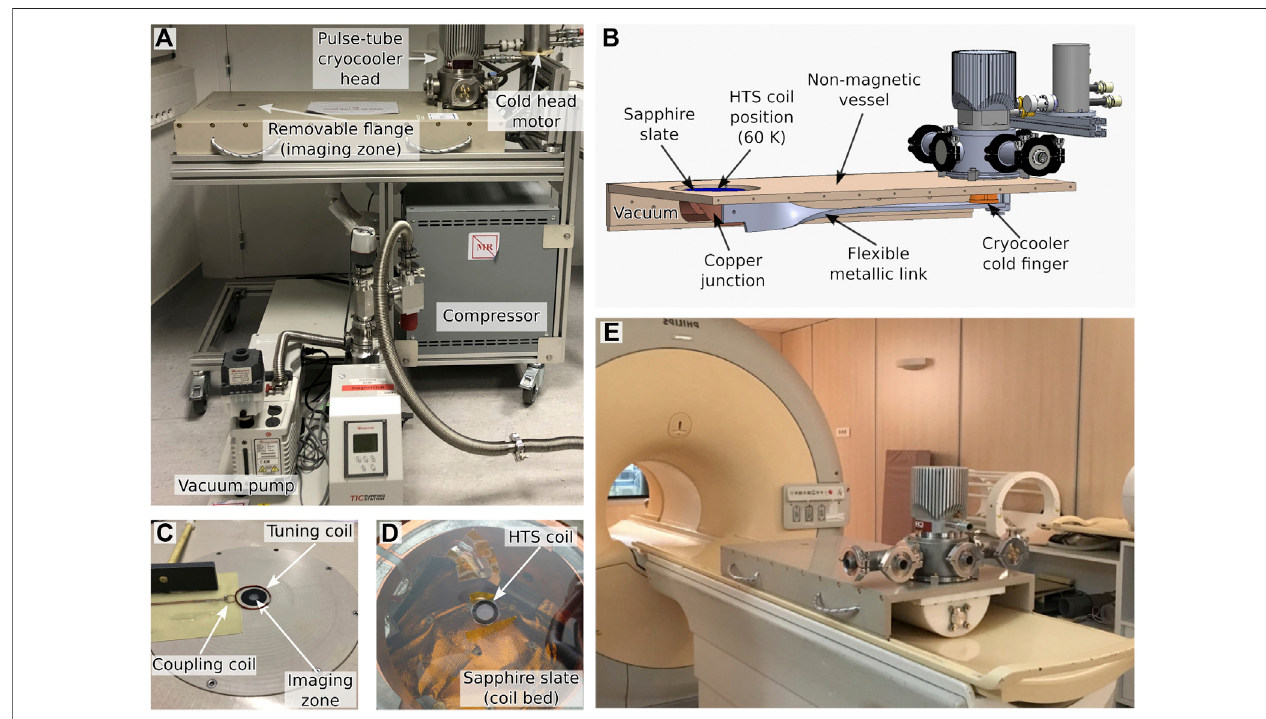
FIGURE2 | Imagesofthe cryogen-free cryostat. (A) The cryostat and associated equipment. (B) Detailed 3D drawing ofthe general layout and cryogenic scheme ofthesystem. (C) TheHTScoilsignalisprobedbyinductivecouplingviathecouplingcoil.MatchingandtuningoftheHTScoiltotheacquisitionchainoftheMRIscanner isperformedwiththecoupling coilandthetuningcoil,respectively.Finetuningisalsoachievedviatemperature controloftheHTS coil. (D) Position oftheHTS coilinside the cryostat, approximately 1.7 mm under the imaging zone. (E) Cryostat on the patient bed which can be inserted in the bore of the 1.5 T MRI scanner. This system was fully described in